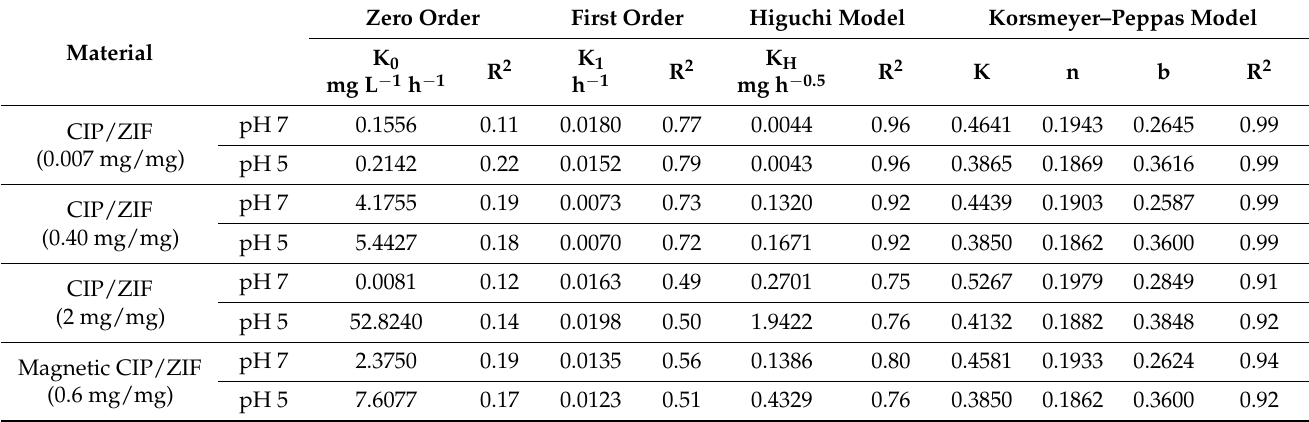
Figure 11. Release profiles of magnetic CIP/ZIF (0.6 mg/mg) in neutral and acid media. Table 1. Kinetic constants and characteristic parameters obtained after applying the kinetic